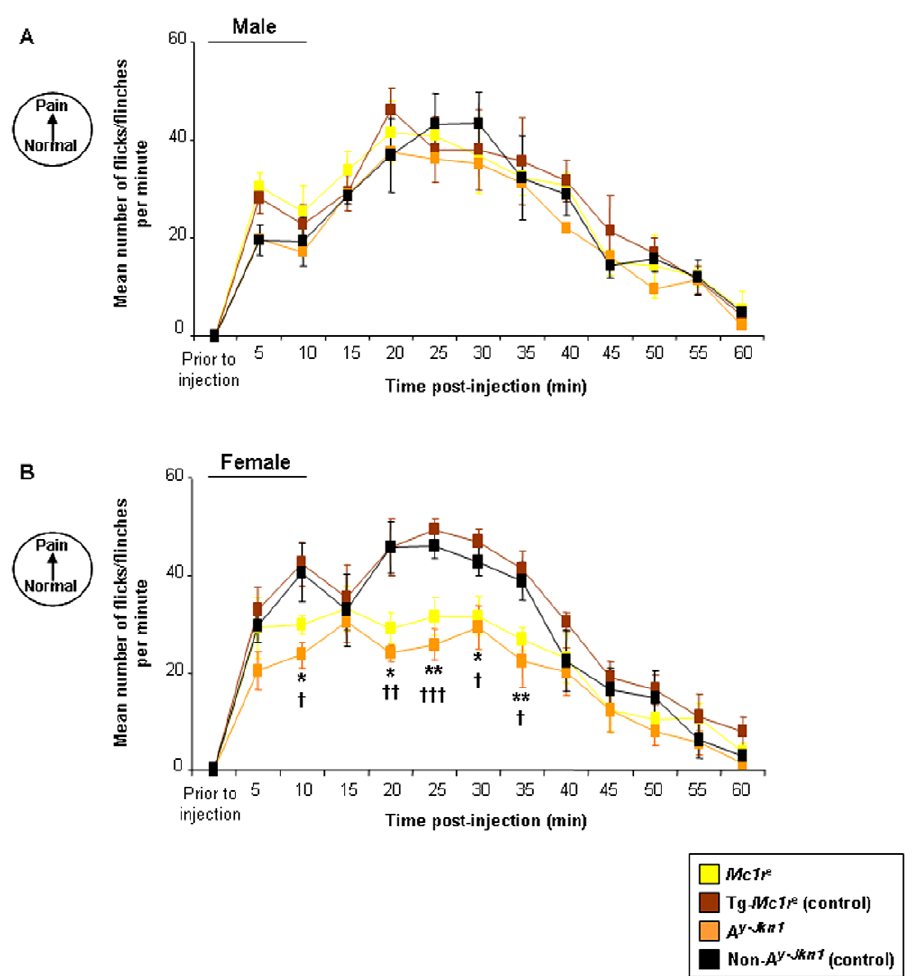
Figure 2. Effect of MC1R functionality on the Formalin Response. Data represents the number of paw flinch or flick responses per min 6 SEM following the intraplantar injection of formalin in [ A ] male and [ B ] female adult Mc1r e , Tg- Mc1r e , A y-Jkn1 and control non- A y-Jkn1 mice (n=5–9 per genotype). There was no significant difference in the formalin response occurring over time (0–60 min post-injection) for male Mc1r e or A y-Jkn1 when compared to their control groups Tg- Mc1r e and control non- A y-Jkn1 respectively. Significant differences for female Mc1r e or A y-Jkn1 when compared to their respective control groups Tg- Mc1r e and control non- A y-Jkn1 are shown *P , 0.05; **P , 0.01 ( Mc1r e compared to Tg- Mc1r e ) and { P , 0.05; {{ P , 0.01; {{{ P , 0.001 ( A y-Jkn1 compared to control non- A y-Jkn1 ).